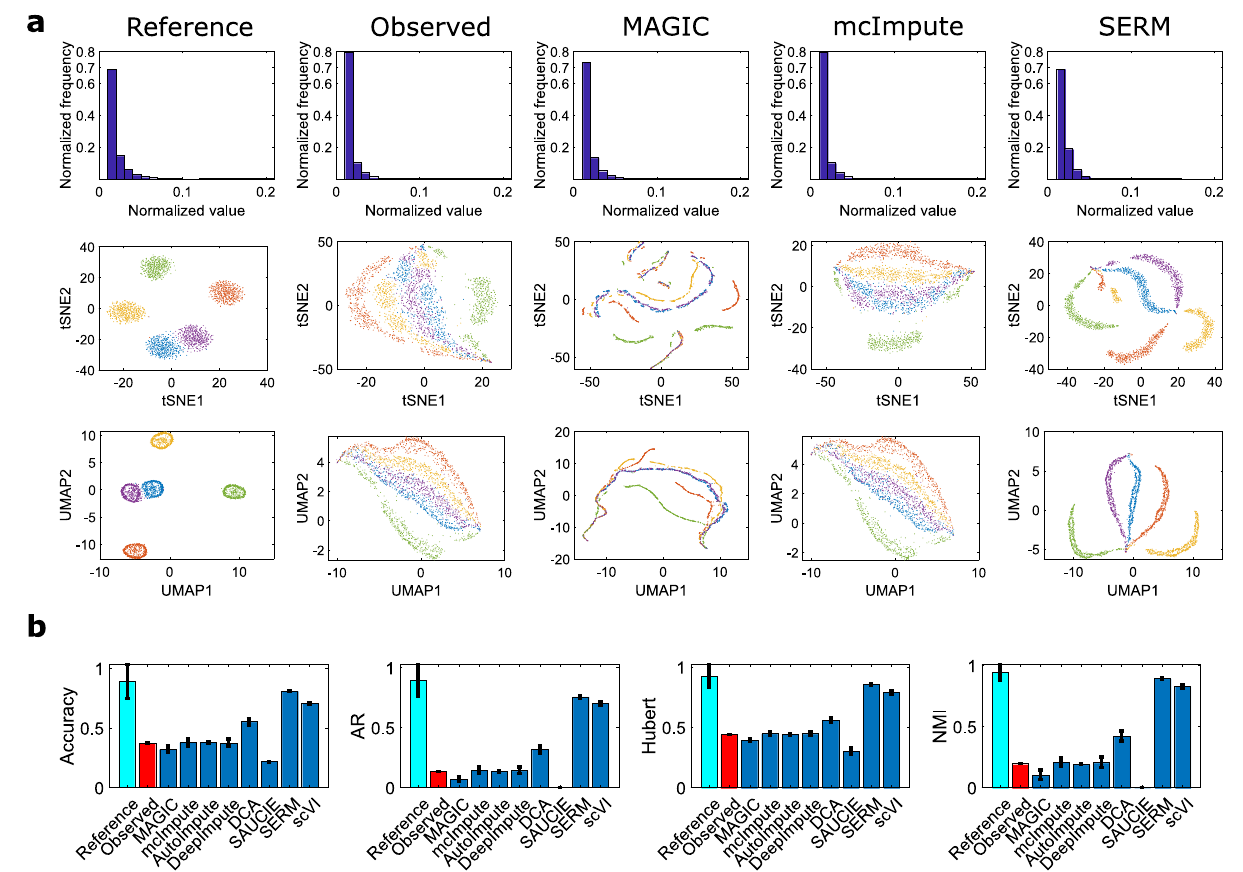
Fig.2|AnalysisofsimulatedscRNA-seqdatawith fi ve classes. Thehistogramsof the reference data, observed data (1% sampling ef fi ciency), and imputed data by MAGIC, mcImpute, and SERM are shown in the fi rst row of ( a ). Visualization of reference,observed,andimputeddatabyt-SNEandUMAPareshowninthesecond and third rows, respectively. t-SNE and UMAP results from SERM imputed data are much better in separating the classes, whereas MAGIC degrades the data due to